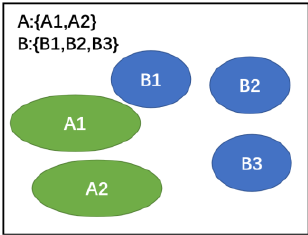
Figure 3. Schematic of positive and negative velocity zone matching. The group A is the velocity area with a smaller number of contours. The group B is the velocity area with a bigger number of